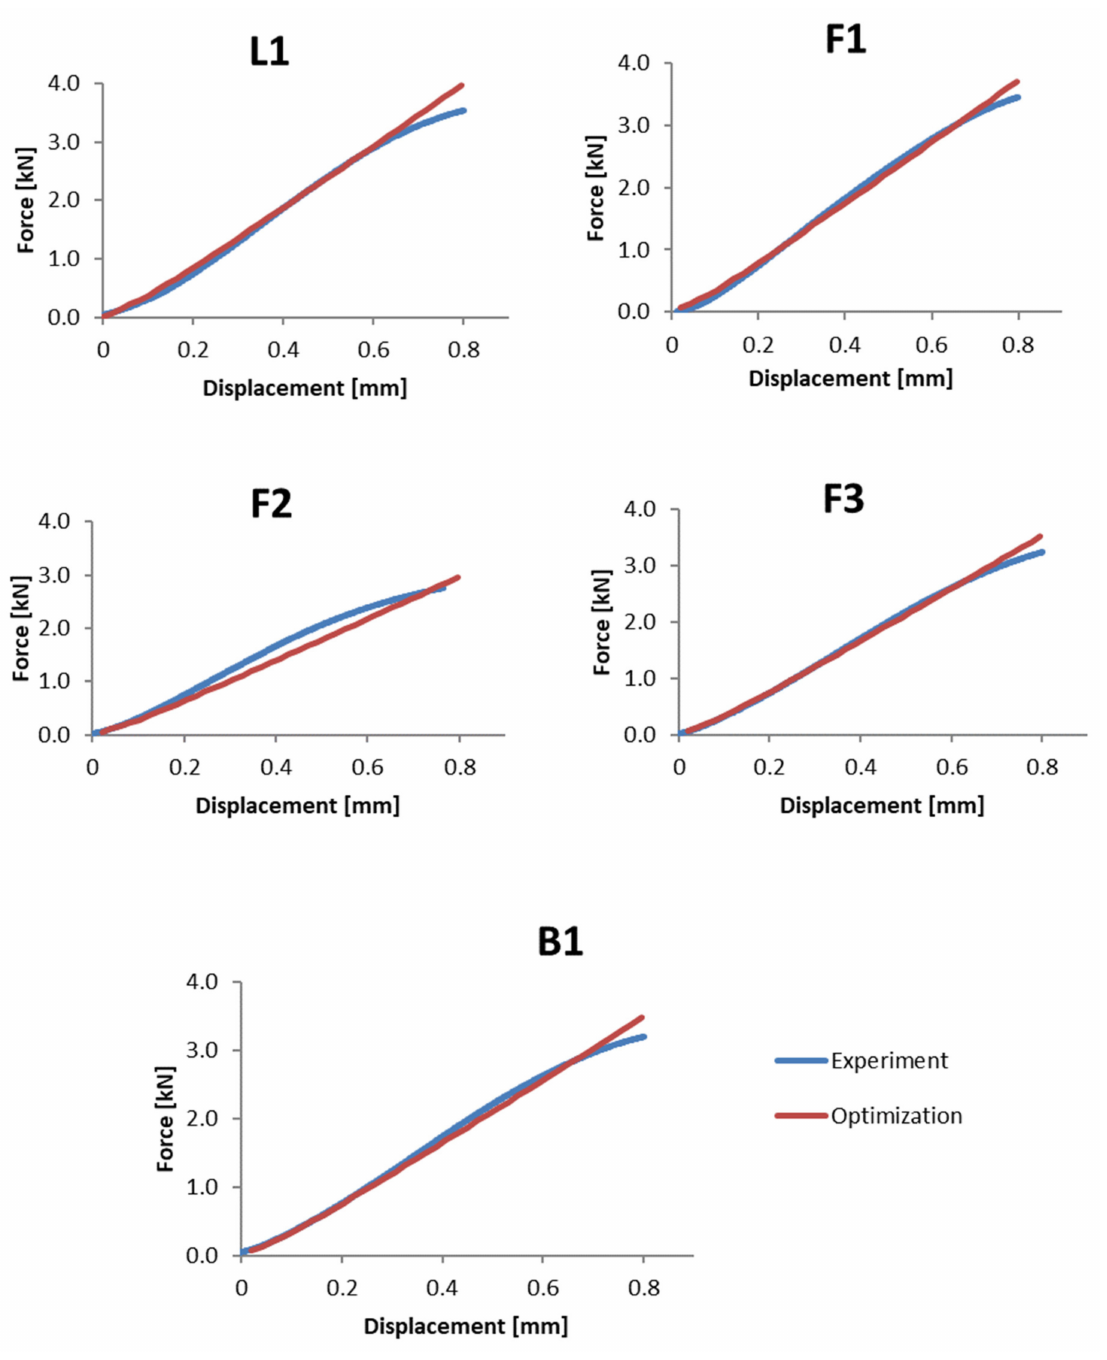
Figure 15. Comparison of the results for the three-point bending test after the numerical optimization of the